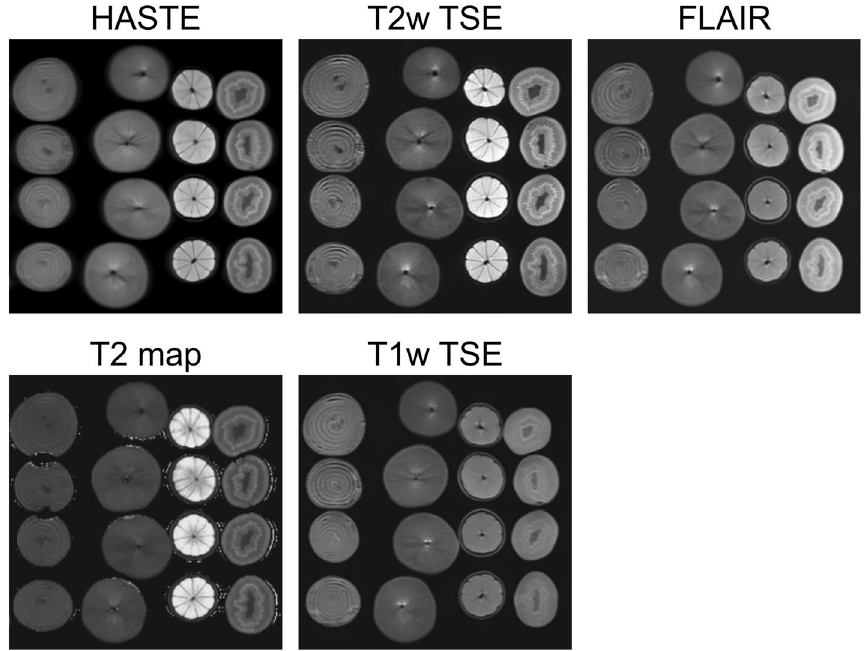
Figure 5. Representative images of the acquired magnetic resonance imaging sequences. FLAIR, fluid- attenuated inversion recovery; HASTE, half-Fourier acquisition single-shot turbo spin-echo; T1w, T1-weighted; T2w, T2-weighted; TSE, turbo-spin-echo.